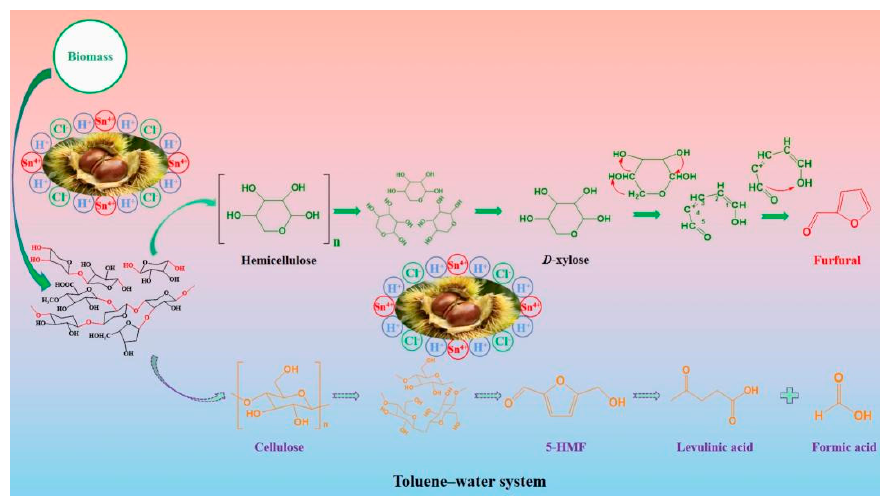
Figure 5. Possible mechanism involving CSUTS-CSW-catalyzed biomass to furfural in toluene–water.